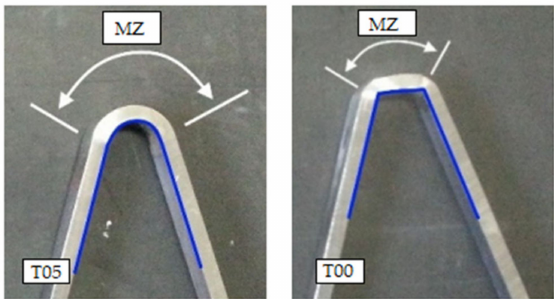
Figure 7. Curvature of the untreated welded sample T00 and the sample